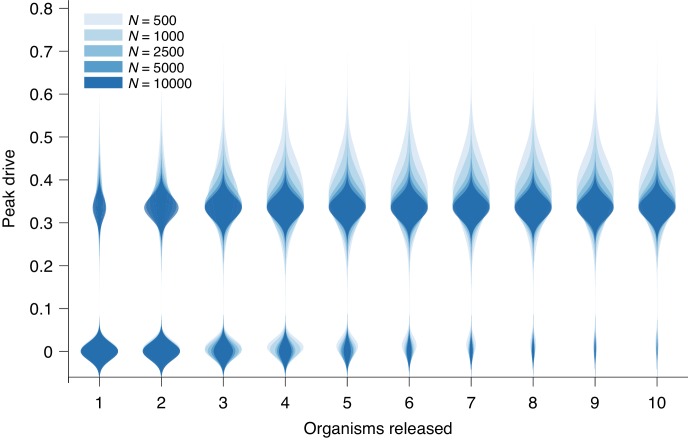
Peak drive distributions for variable release and population sizes.Parameters are chosen to correspond to Figure 1E: P=0.5, f=0.9 and neutral resistance. Population sizes are, from light to dark, N=500,1000,2500,5000,10000. Note that N=500 corresponds exactly to Figure 1E. Each distribution corresponds to 103 simulations.